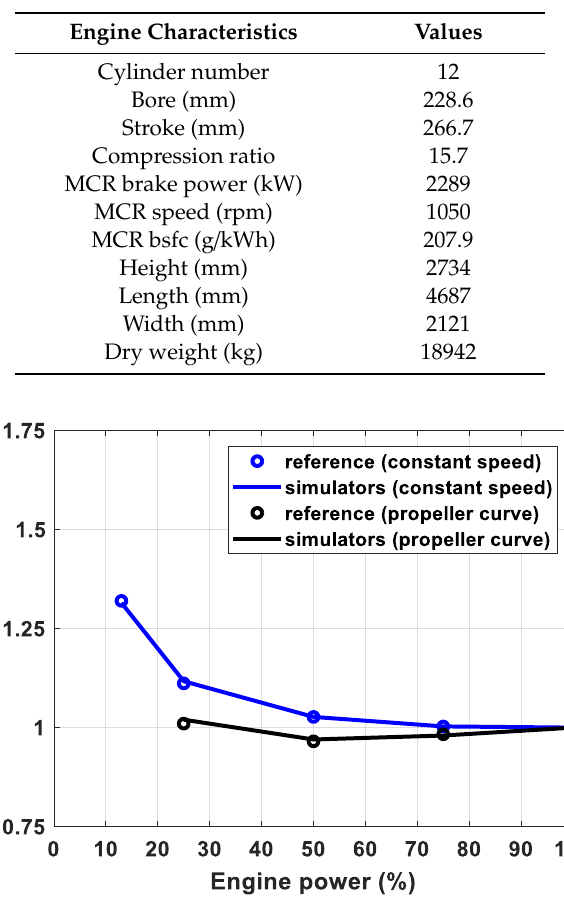
Table 2. Motor-yacht characteristics.